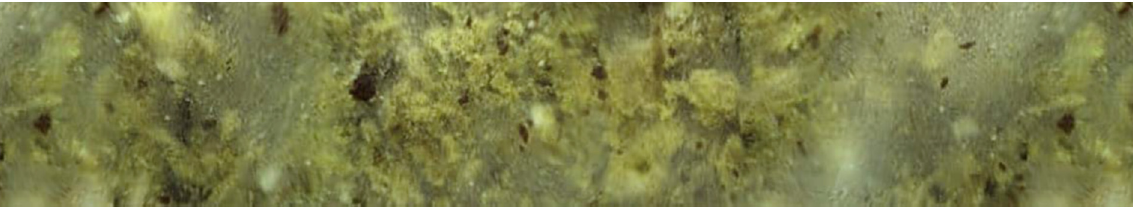
Figure 7. Video capsule enteroscopy. Porcine ileum with remnants of digested food.